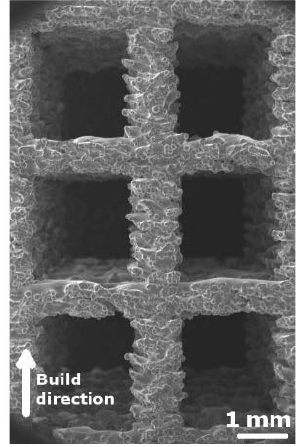
Figure 10. Intact 0.5 mm struts produced using the modified contour strategy.